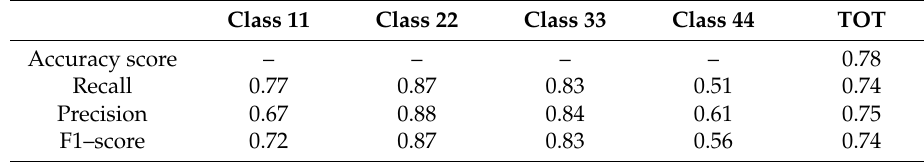
Table 5. Accuracy parameters obtained in ML classification processing.